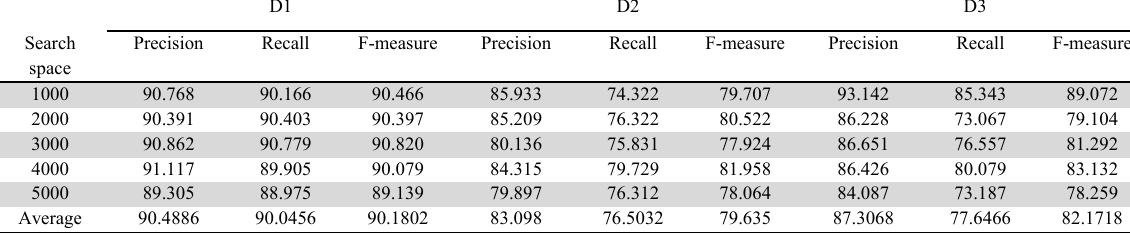
Performance of GARC (macro average %) for each dataset based on the top ranked features using